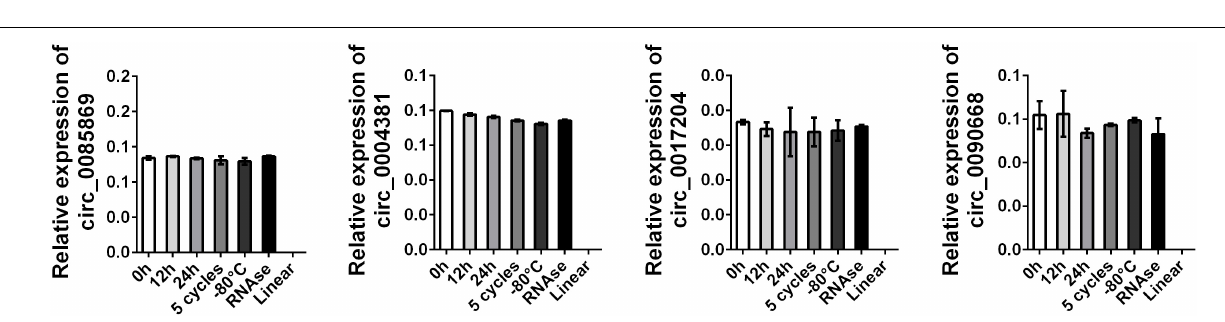
Frontiers in Aging Neuroscience |